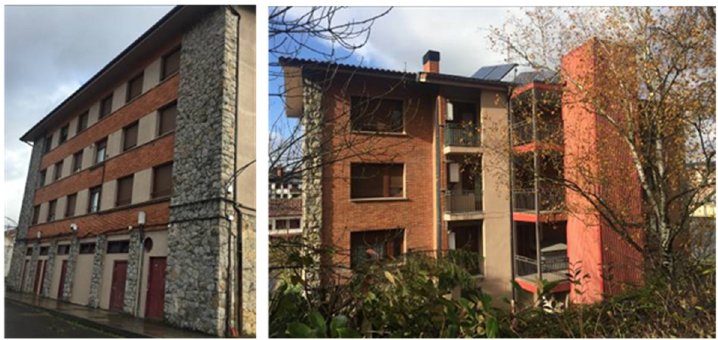
Figure 13. Pictures of the façade of the existing building located in Durango (Spain).